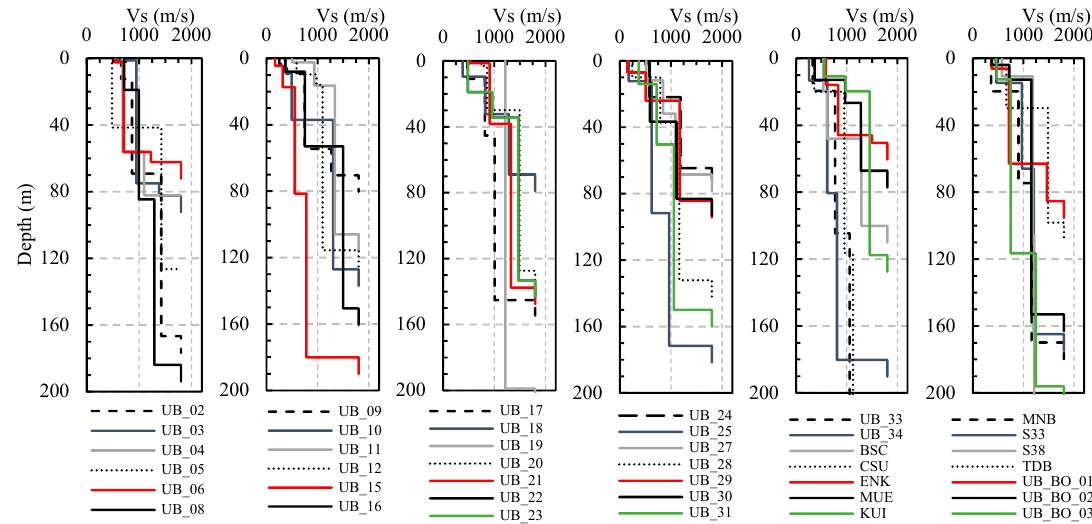
Figure 6. Estimated shear-wave velocity profiles of all sites obtained from microtremor single inversions.